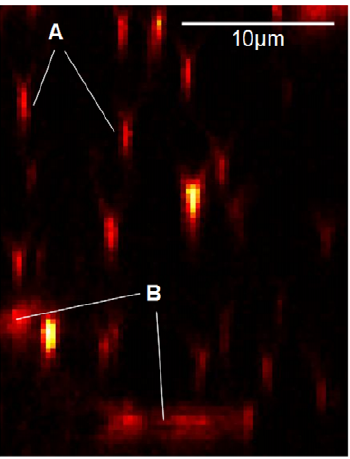
Figure 4. x-z cross-section of a 3D image stack. (A) Perpendicular cross-sections of collagen fibers appear as elliptical spots of finite size that can be easily recognized by 2D template matching. (B) The shape of the spot varies as the angle of intersection becomes less than 90 degrees. For angles less than 45 degrees, the distortion of the spot can become too large to match the